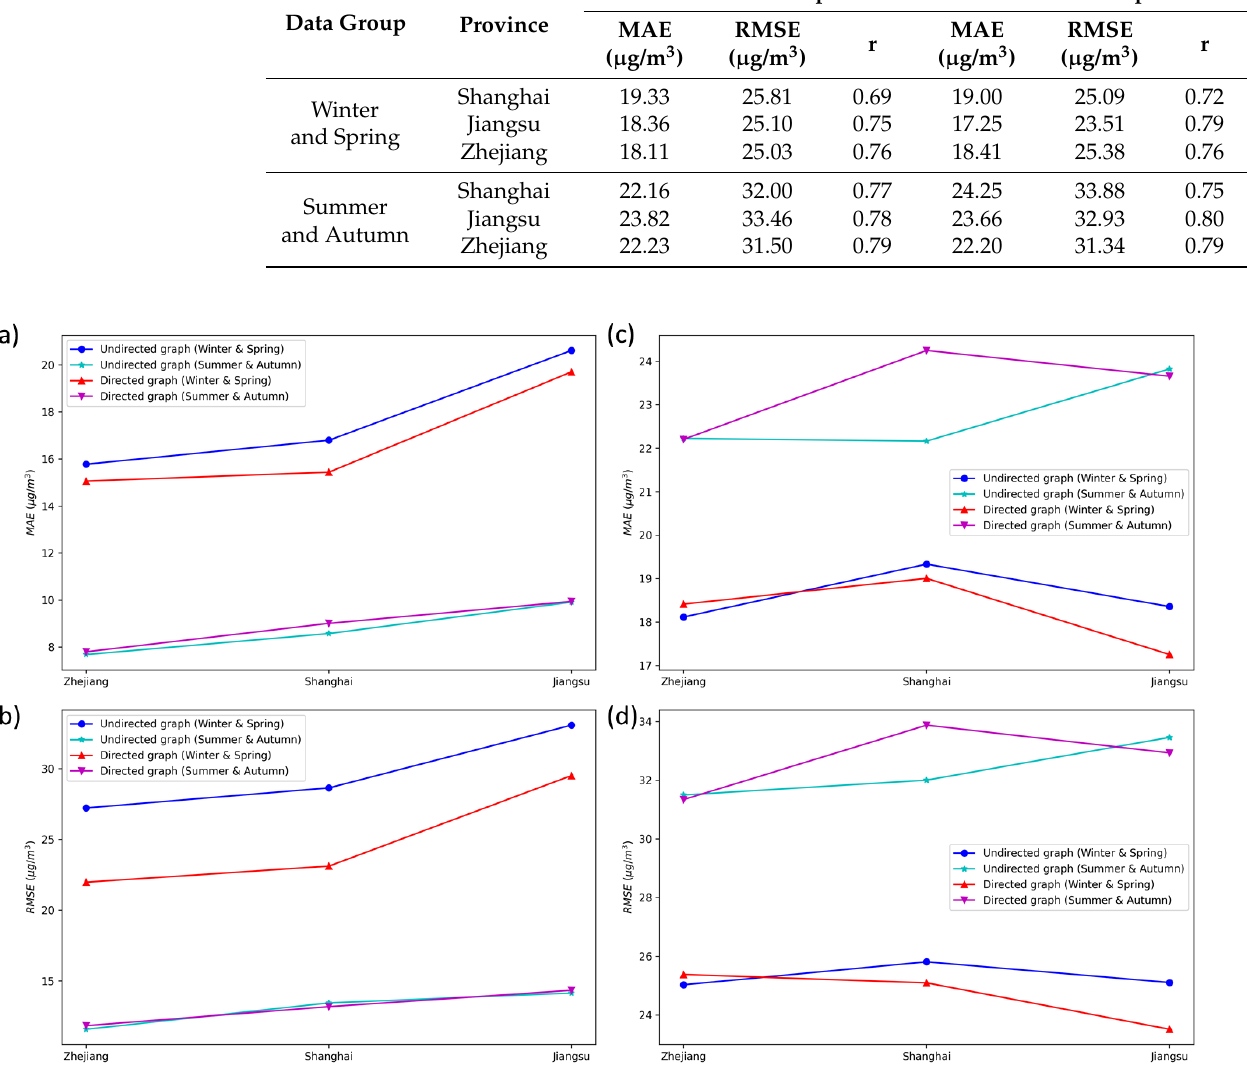
Figure 6. Model comparison between the DCRNN model and baseline models. ( a ) PM 2.5 , MAE; ( b ) PM 2.5 , RMSE; ( c ) ozone, MAE; ( d ) ozone, RMSE.